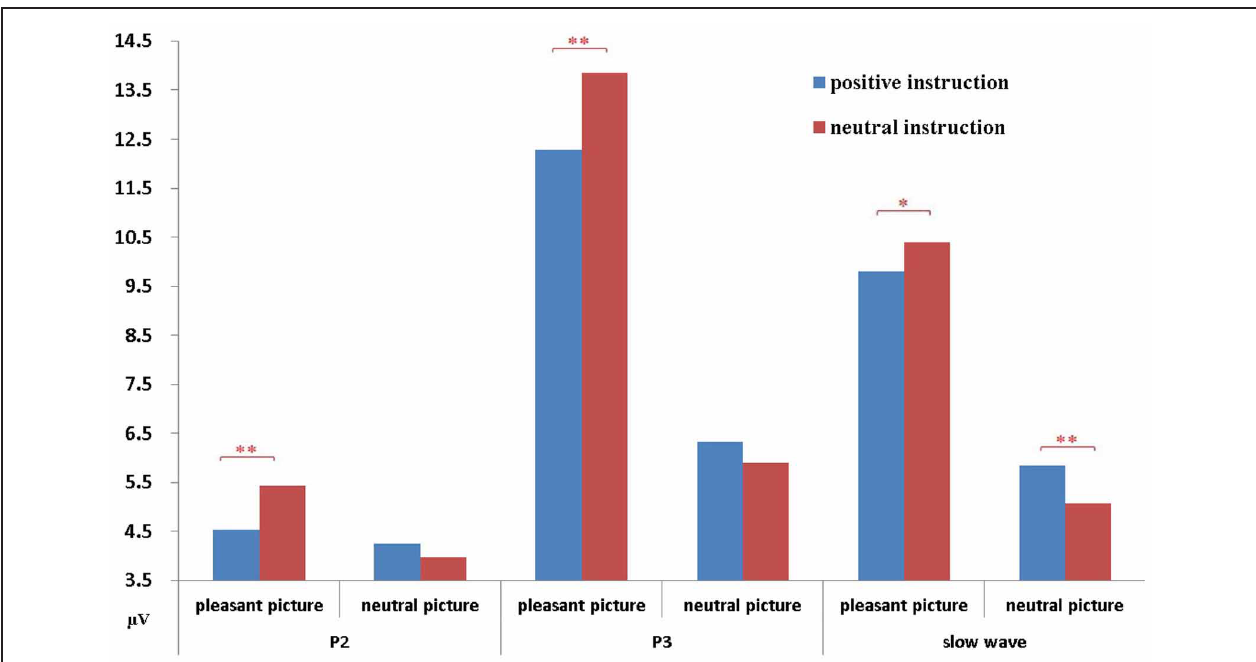
FIGURE 4 | The effects of instruction-type on P2, P3, and the slow wave component. Instruction-type had different effects on picture type for P2, P3, and the slow wave components; error bars represent standard errors. ∗ α < 0 . 05, ∗∗ α < 0 .